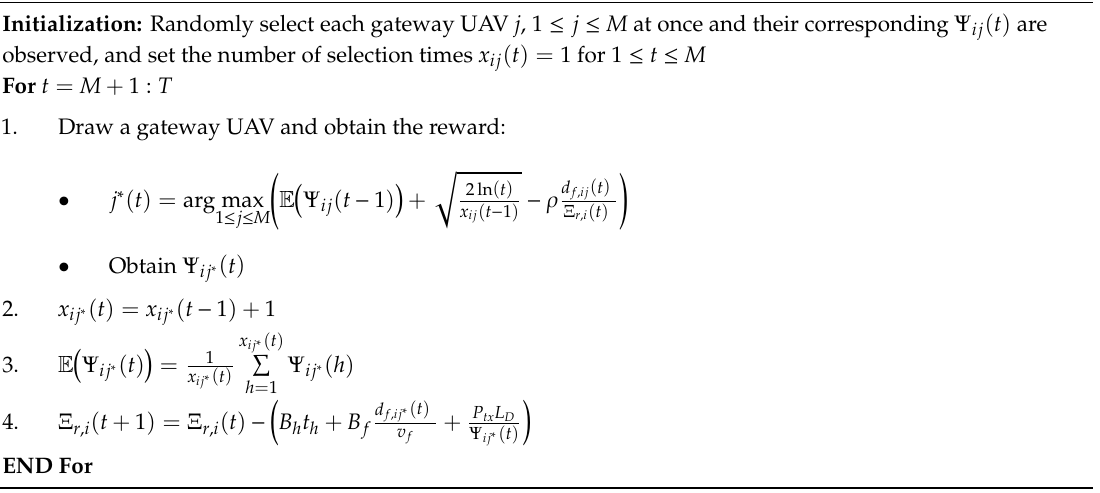
Algorithm 1: BA-UCB gateway UAV